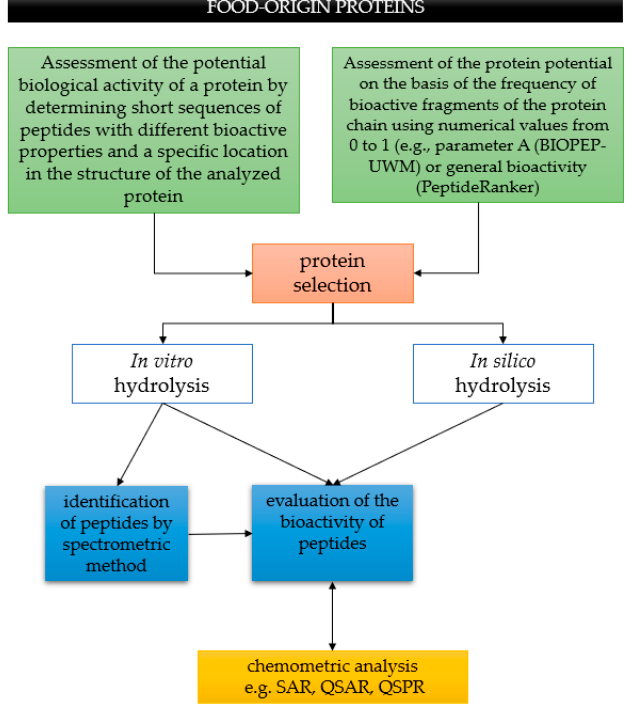
Figure 4. Workflow for assessing the biological potential of food proteins—scheme.